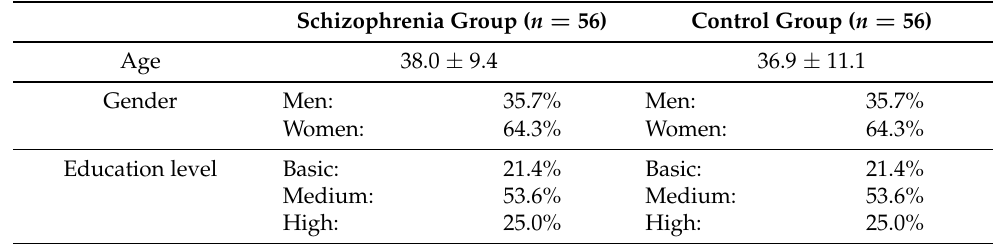
Table 1. Sociodemographic data of the samples. Schizophrenia Group ( n = 56)